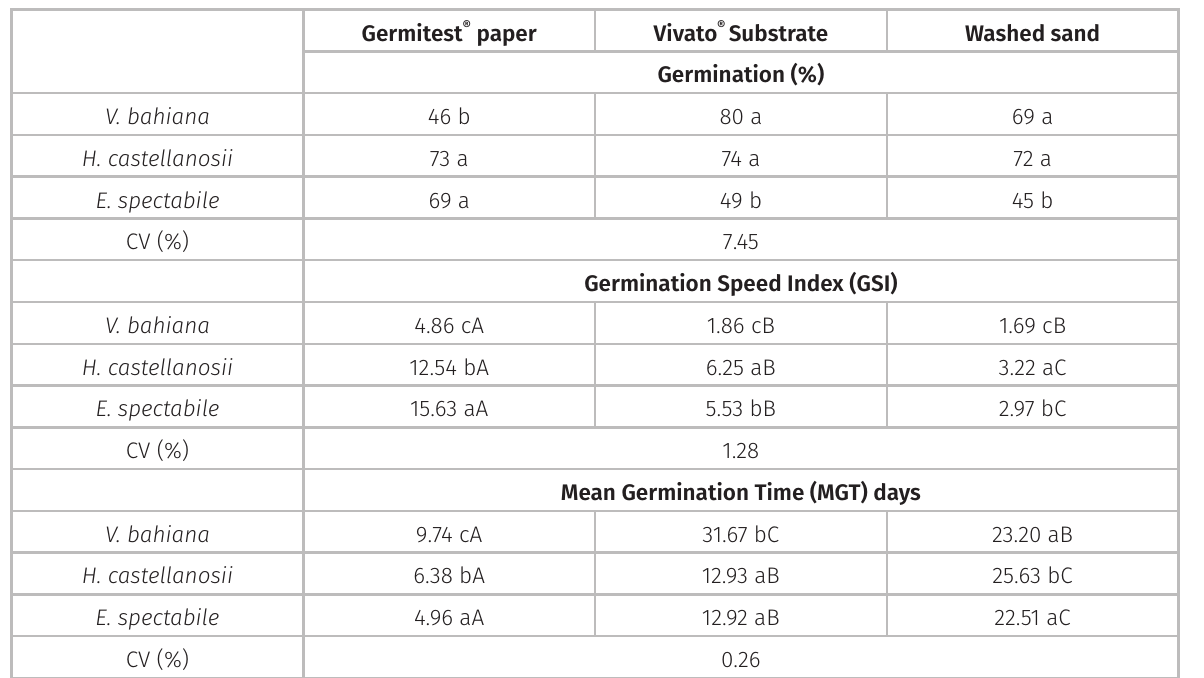
Table II. Germination percentage, germination speed index and mean germination time of three bromeliad species in different substrates.